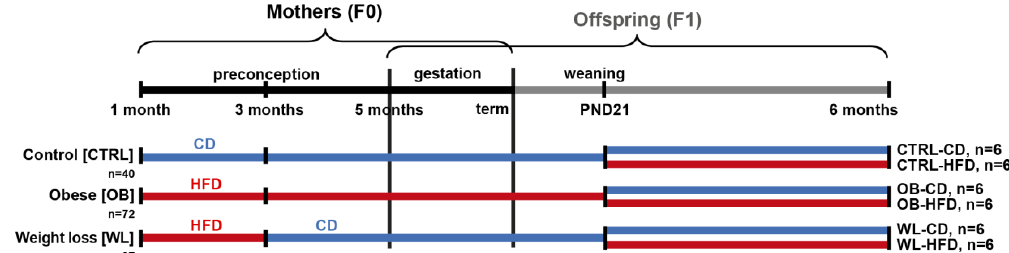
Figure 1. Animal model of preconception maternal weight trajectories . C57BL/6J F0 females were fed a control diet (CD, blue), a high-fat diet (HFD, red) or an HFD for two months and then switched